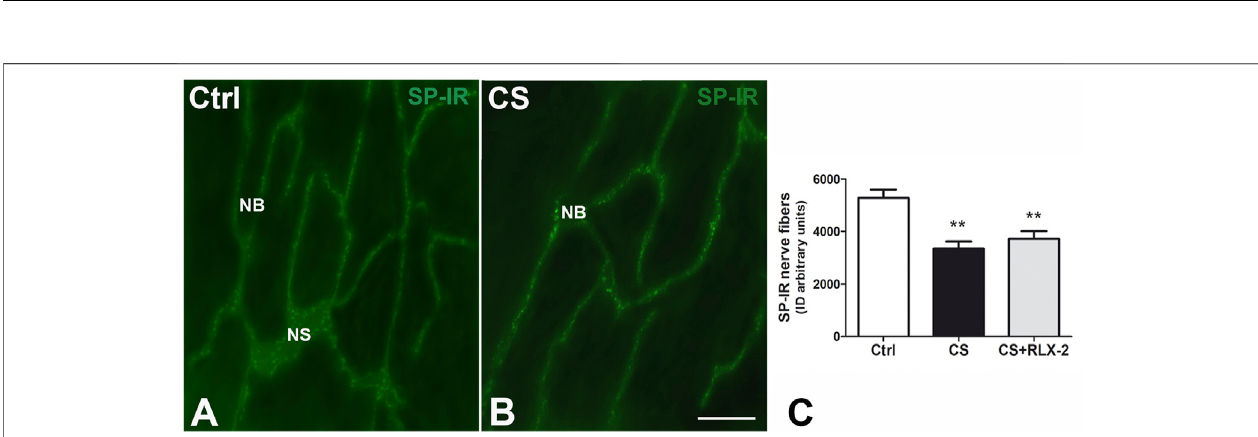
FIGURE7| DecreaseinsubstanceP(SP)-immunoreactive(IR)nerve fi bersinthesubmucosainthecolonofthecigarettesmoke(CS)groupandeffectsofrelaxin-2 (RLX-2). (A,B) Laminae, submucosa. SP-IR was located in numerous nerve fi bers that formed nerve bundles ( NB ) and in the nerve strands ( NS ). (C) The SP-IR nerve fi bers signi fi cantly increased in CS-exposed animals. This increase was insensitive to RLX-2 treatment. Bar , 50 μ m (A , B) . ** p < 0.005.